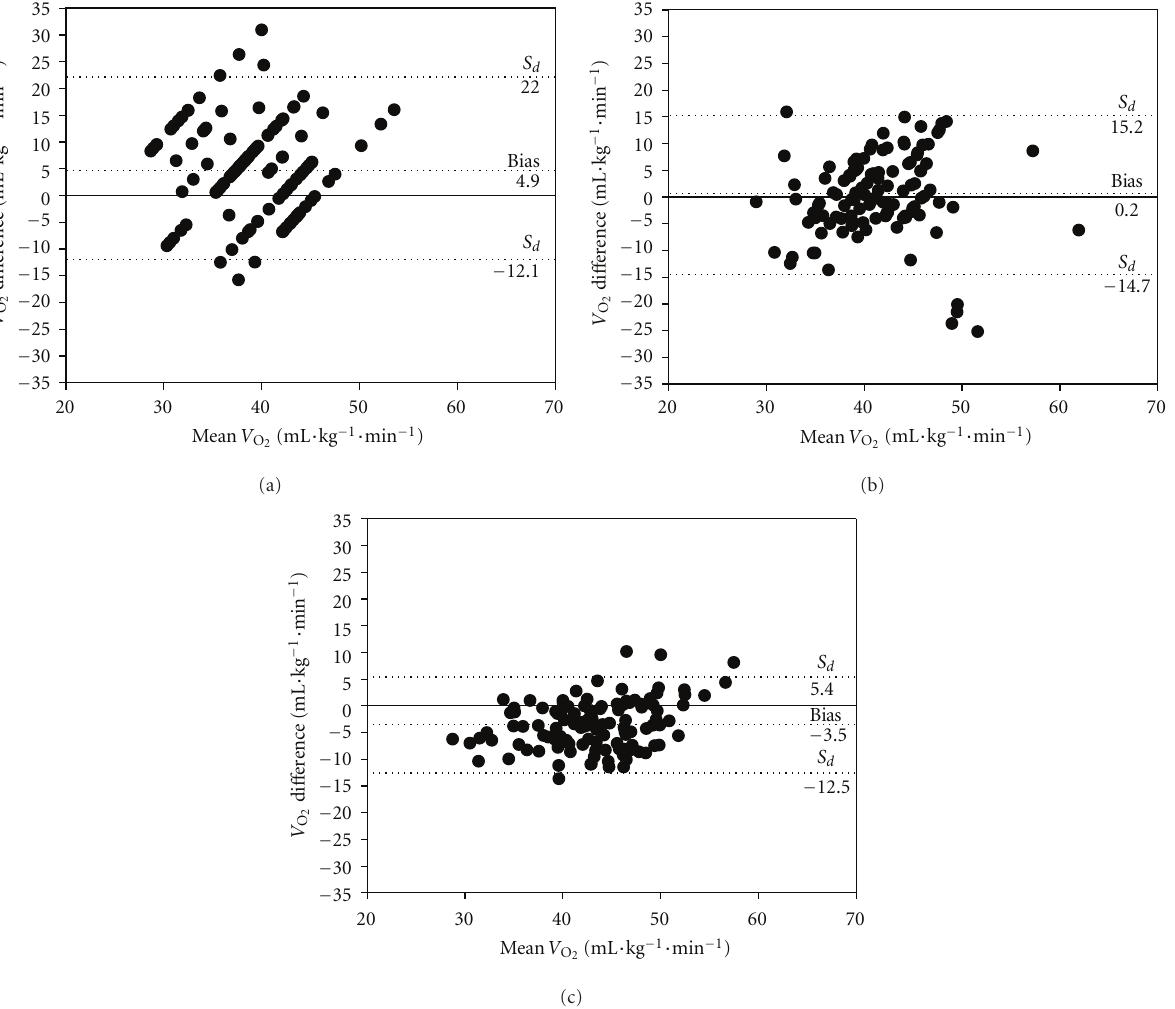
Figure 2: Bland-Altman plot for the individual di ff erences between V O and CRF (c). The first and third horizontal dashed lines in each graph represent the 95% limits of agreement for VSAQ, RPC, CRF, and VSAQ, corresponding, respectively, to − 12.1 to 22.0 ( − 29.1 to 53.0%); − 14.7 to 15.2 ( − 35.5 to 36.6%); − 12.5 to 5.4 ( − 30,0% to 13,0%). S d : standard deviation of the di ff erences.